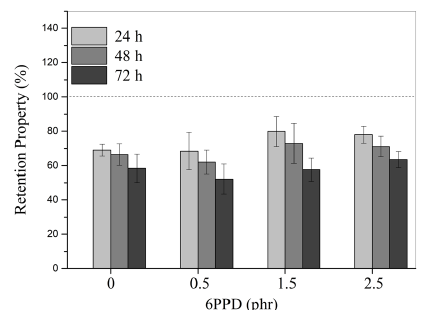
Figure 6. Retention of tear resistance in oven thermo-oxidative aging comprising 1.0 phr of TMQ in combination with different 6PPD contents.